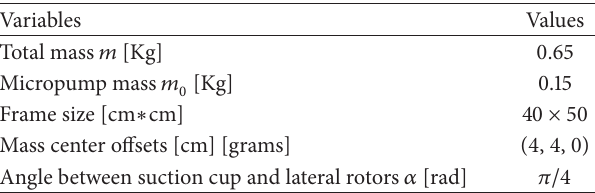
Table 1: Parameters of the robot system.